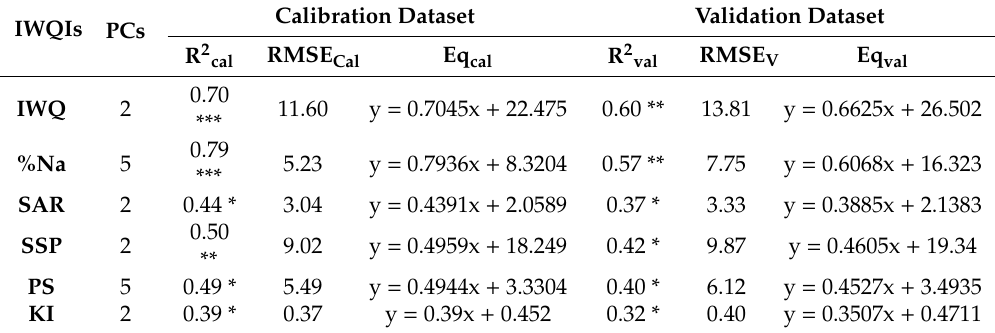
Table 7. Coe ffi cient of determination (R 2 ), root mean squared error (RMSE), and regression equation (Eq) for calibration (R 2 cal , RMSE Cal , and Eq cal ) and validation (R 2 val , RMSE Val , and Eq val ) statistics of partial least squares regression (PLSR) models based on the full-spectrum ranges (302–1148 nm) for the assessment of di ff erent irrigation water quality indicators (IWQIs): irrigation water quality (IWQ), percent sodium (%Na), sodium absorption ratio (SAR), soluble sodium percentage (SSP), potential salinity (PS), and Kelly’s index (KI). Estimates were calculated across the Western Desert and Central Nile Delta ( n = 40). Calibration Dataset Validation Dataset IWQIs PCs